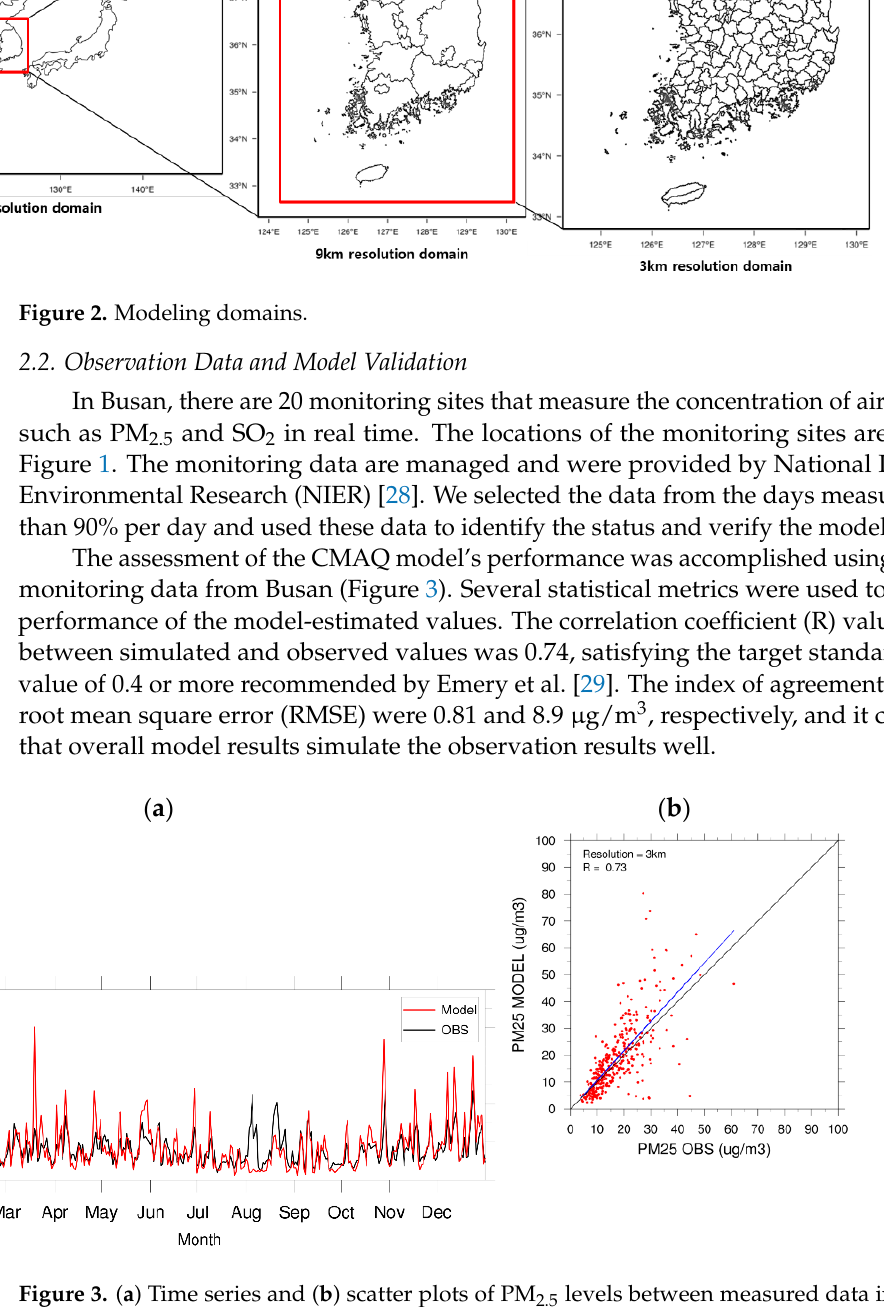
AQMS and simulated data measured by the CMAQ in